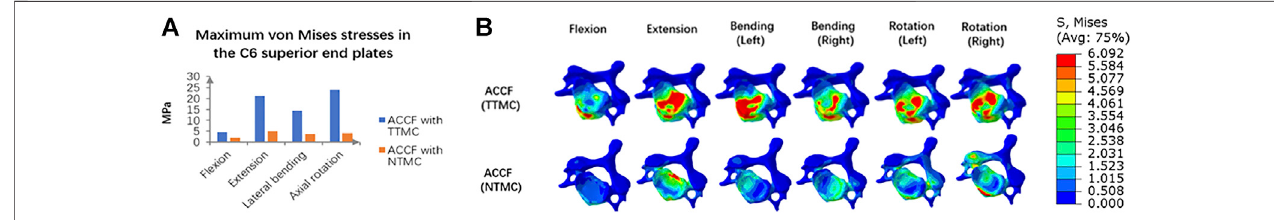
FIGURE 6 | (A) Comparisons ofthe maximum von Mises stressesin the C6 superior endplate between the TTMC and NTMC models; (B) Stress cloud map of the C6 superior endplates between TTMC and NTMC models.